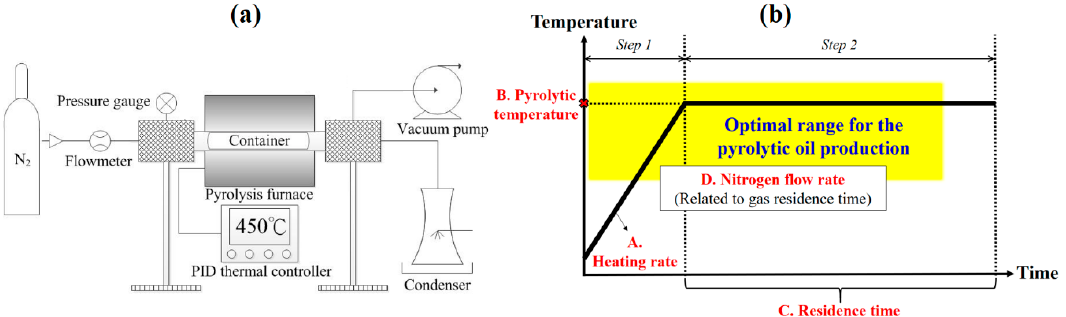
Figure 2. Schematic diagram of ( a ) experimental setup and ( b ) operating process for thermal pyrolysis. Simultaneous thermogravimetric analysis (TGA) and differential scanning calorimetry (DSC) measurement were performed using the thermal analyzer (PerkinElmer, Waltham, MA, USA: STA